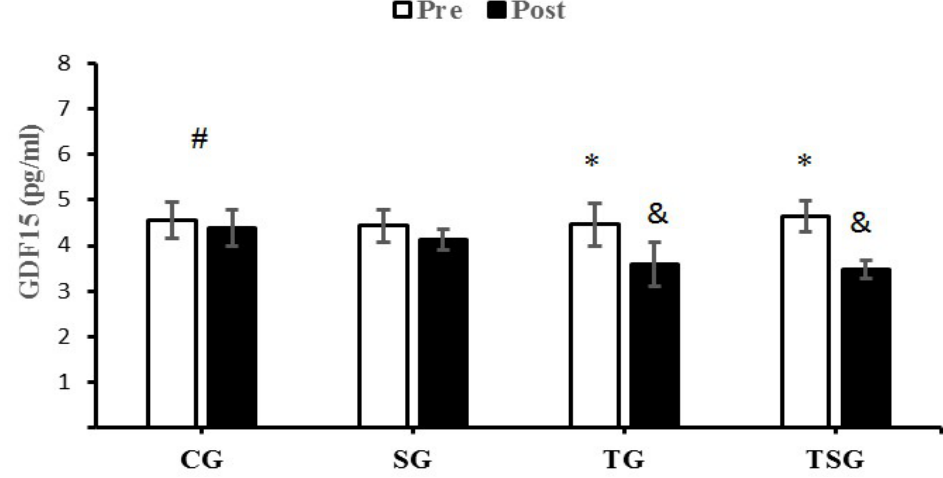
Figure 4. Pre- and post-training values (mean ± SD) for GDF15 in the control (CG), supplement (SG), training (TG), training + supplement (TSG) groups. & Significantly different from pretest values ( p < 0.05). * Significantly different from CG ( p < 0.05). # Significant time X group interaction ( p < 0.05).